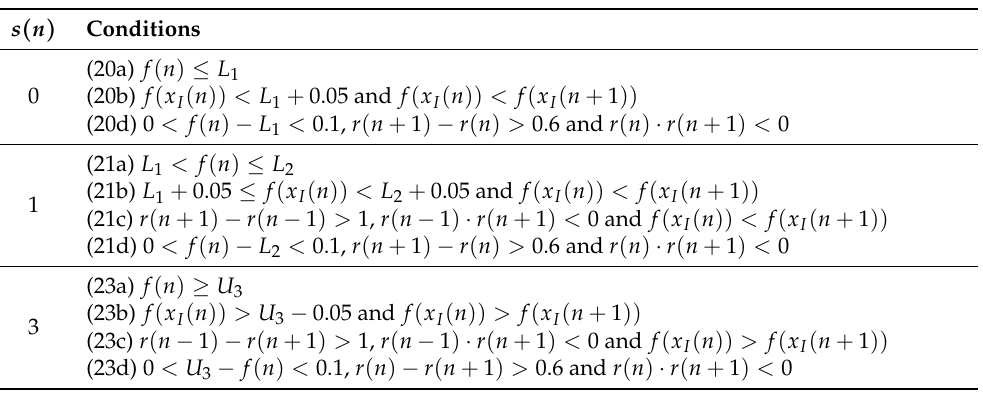
Table 4. Conditions for status change with s ( n − 1 ) = 2.